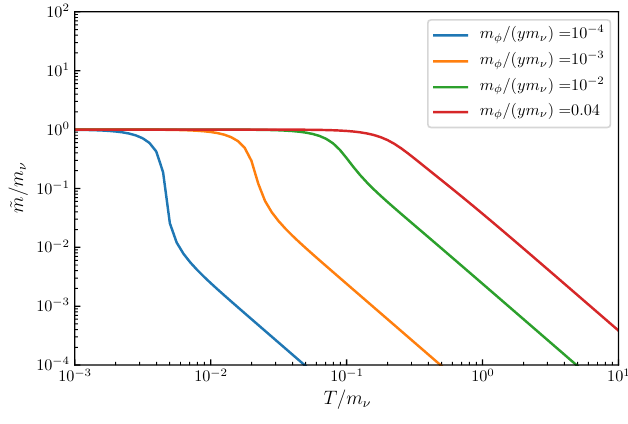
Figure 6 . Dependence of the effective neutrino mass ˜ m ν on T/m ν for different values of m φ .